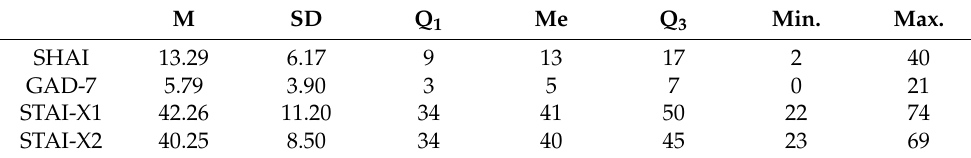
Table 2. Summary of descriptive statistics of the standardised research